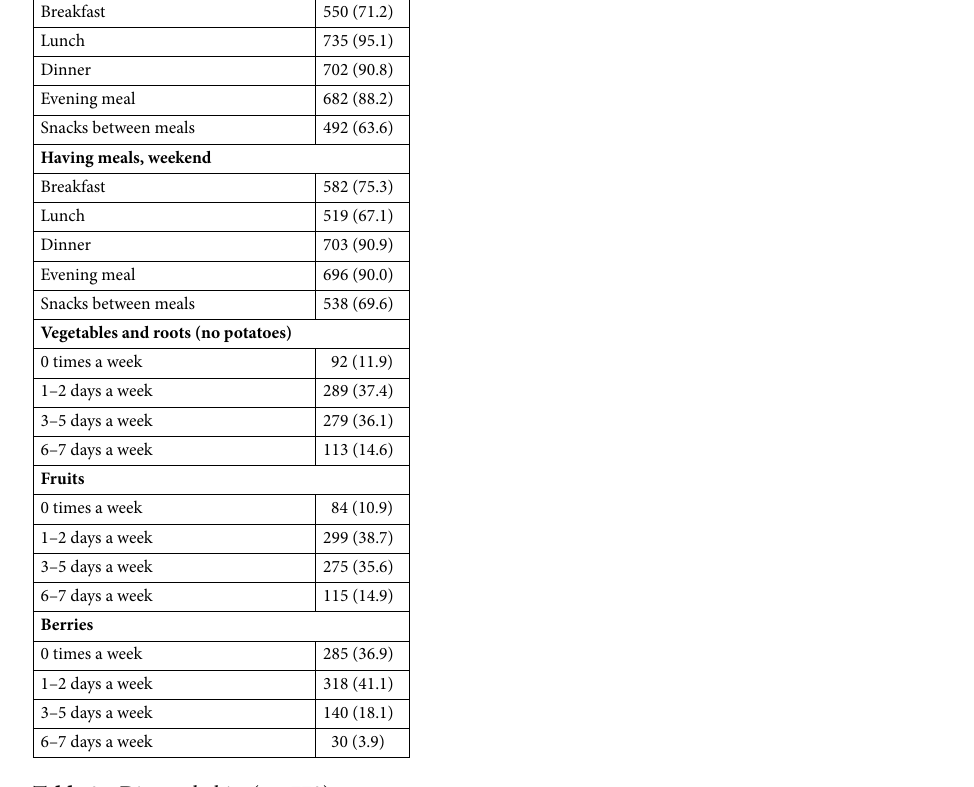
Table 2. Dietary habits (n =